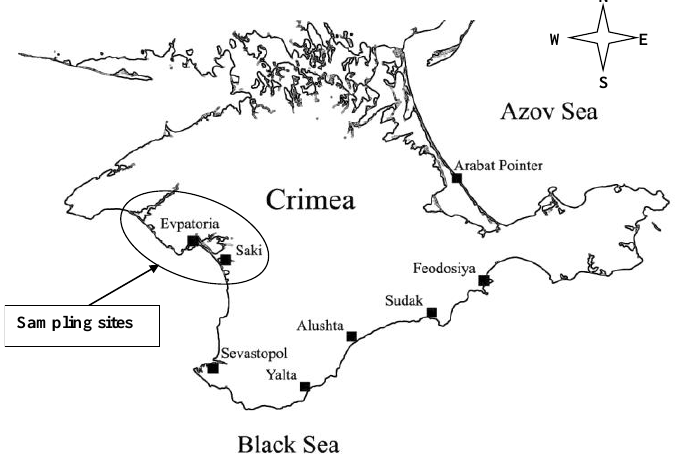
Figure 1. Location of Saki Lake.